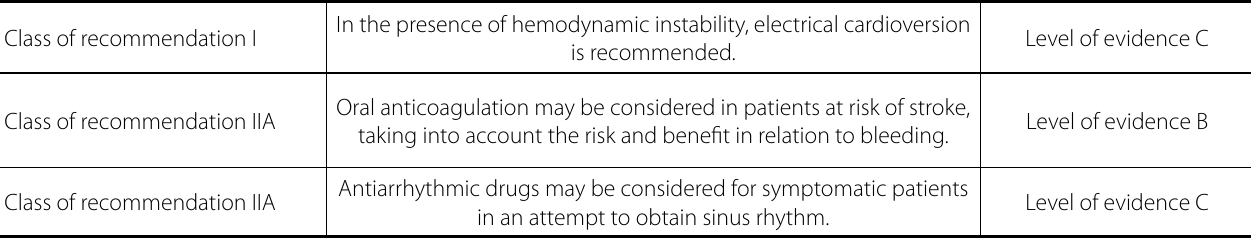
Table 1 . Therapeutic guidelines for postoperative atrial fibrillation [37] .